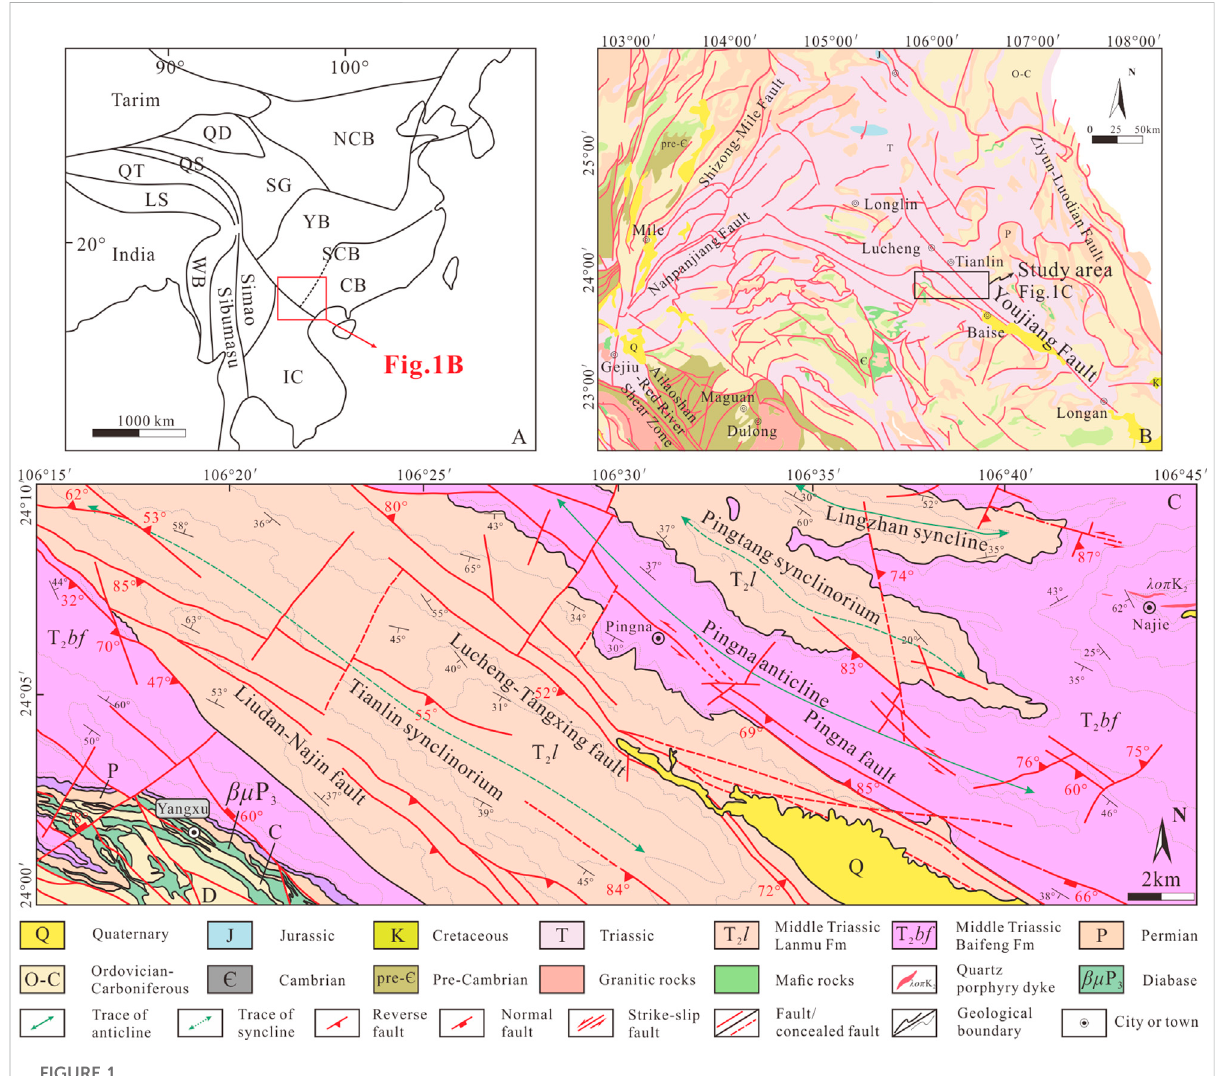
FIGURE 1 (A) SketchmapofSouthChinaanditsadjacentregions(modi fi edfromQiuetal.,2019). (B) GeologicalmapoftheYoujiangBasin(modi fi edfrom Yang et al., 2021). (C) Geological map of the central segment of the YFTB in the Youjiang Basin. Abbreviations: NCB, North China block; SCB, South China block; CB, Cathaysian block; YB, Yangtze block; IC, Indochina block; SG, Songpan – Ganzi accretionary complex; QD, Qaidam block;